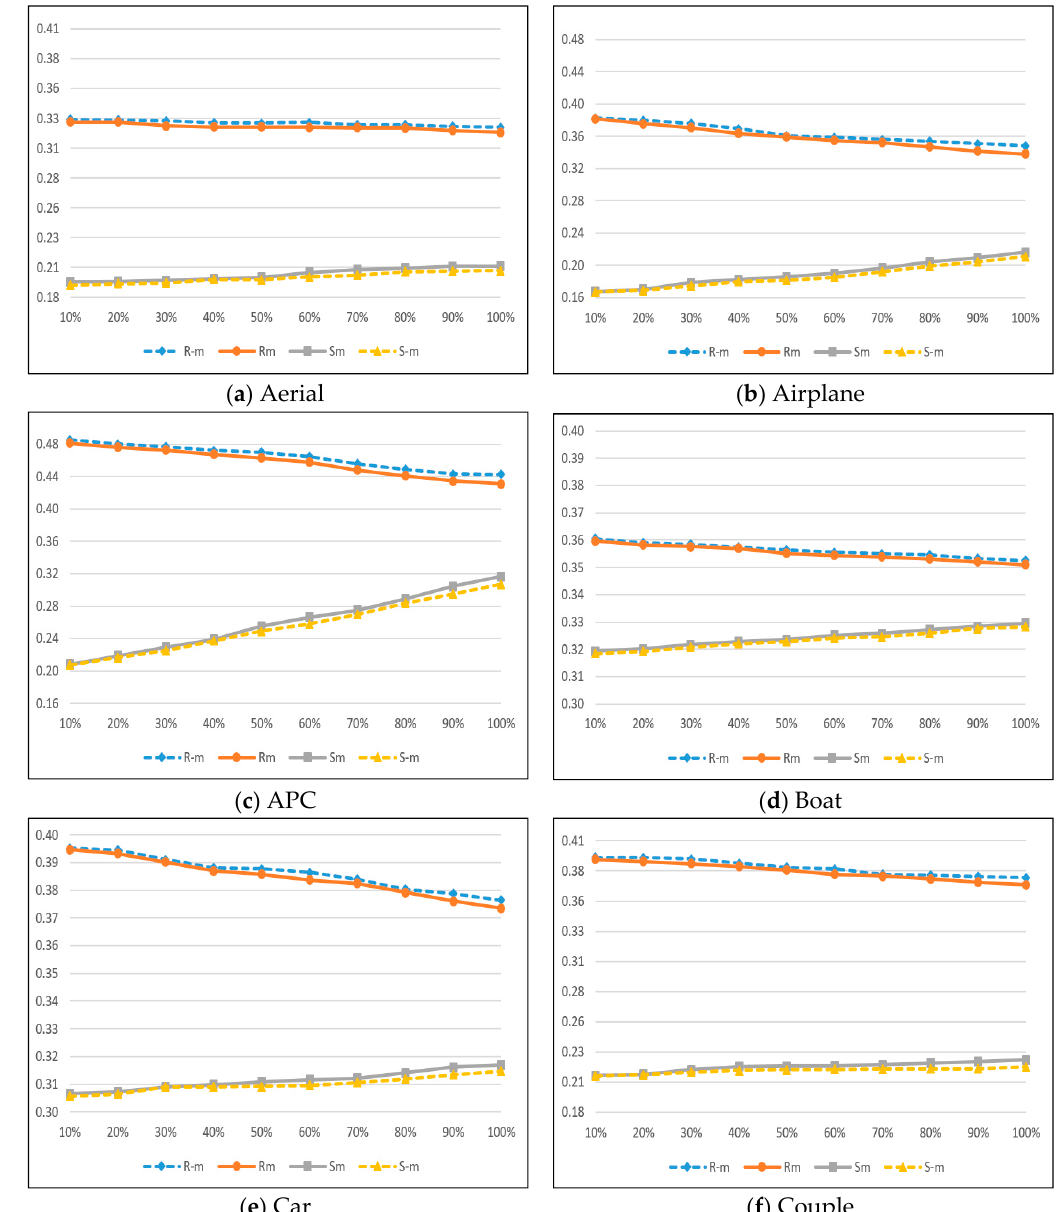
Figure 7. Comparison graphs for RS analysis from USC-SIPI [24] dataset. The figures are ( a ) Aerial, ( b ) Airplane, ( c ) APC, ( d ) Boat, ( e ) Car, and ( f ) Couple.